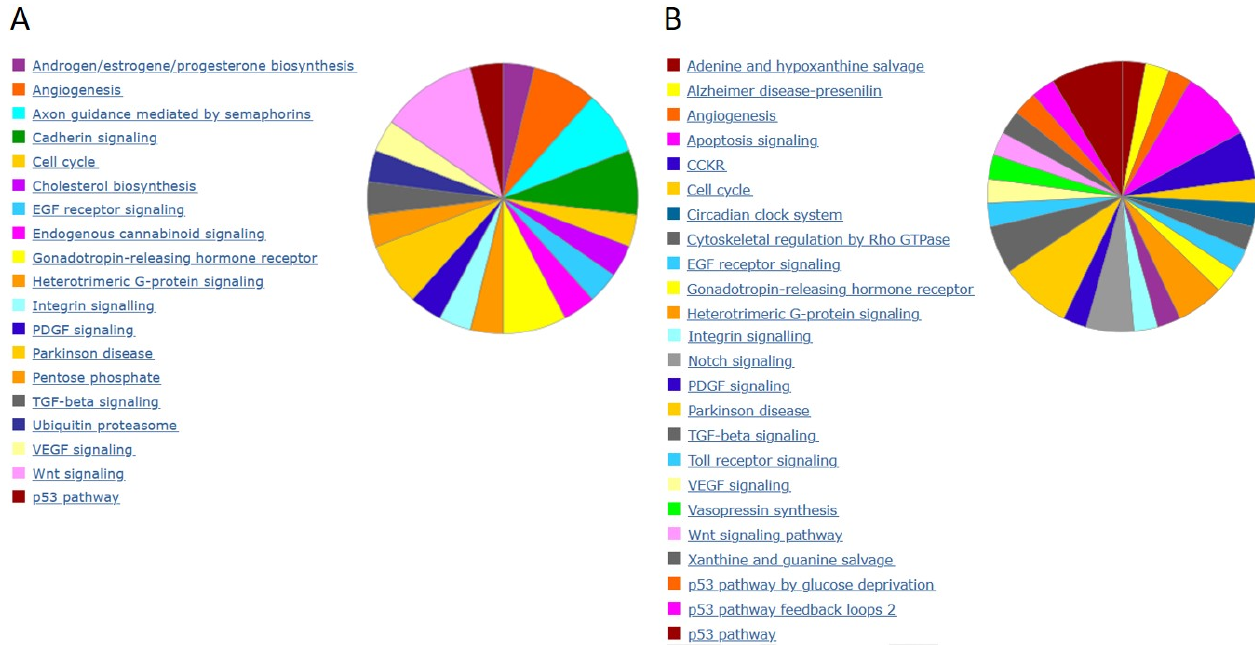
Figure 5. Hierarchical clustering of 6 tissue samples from BPH prostate glands, 8 samples of tumor-adjacent gland tissue (tu adja.), and 20 PCa tumor tissue samples (pT). It is performed using the correlation metric and the average linkage method. Illustrates relationship and group building based on distinct common DNA methylation signatures out of 2.0 million CpG-rich 60-nucleotide probes distributed over all CpG islands of the whole genome.